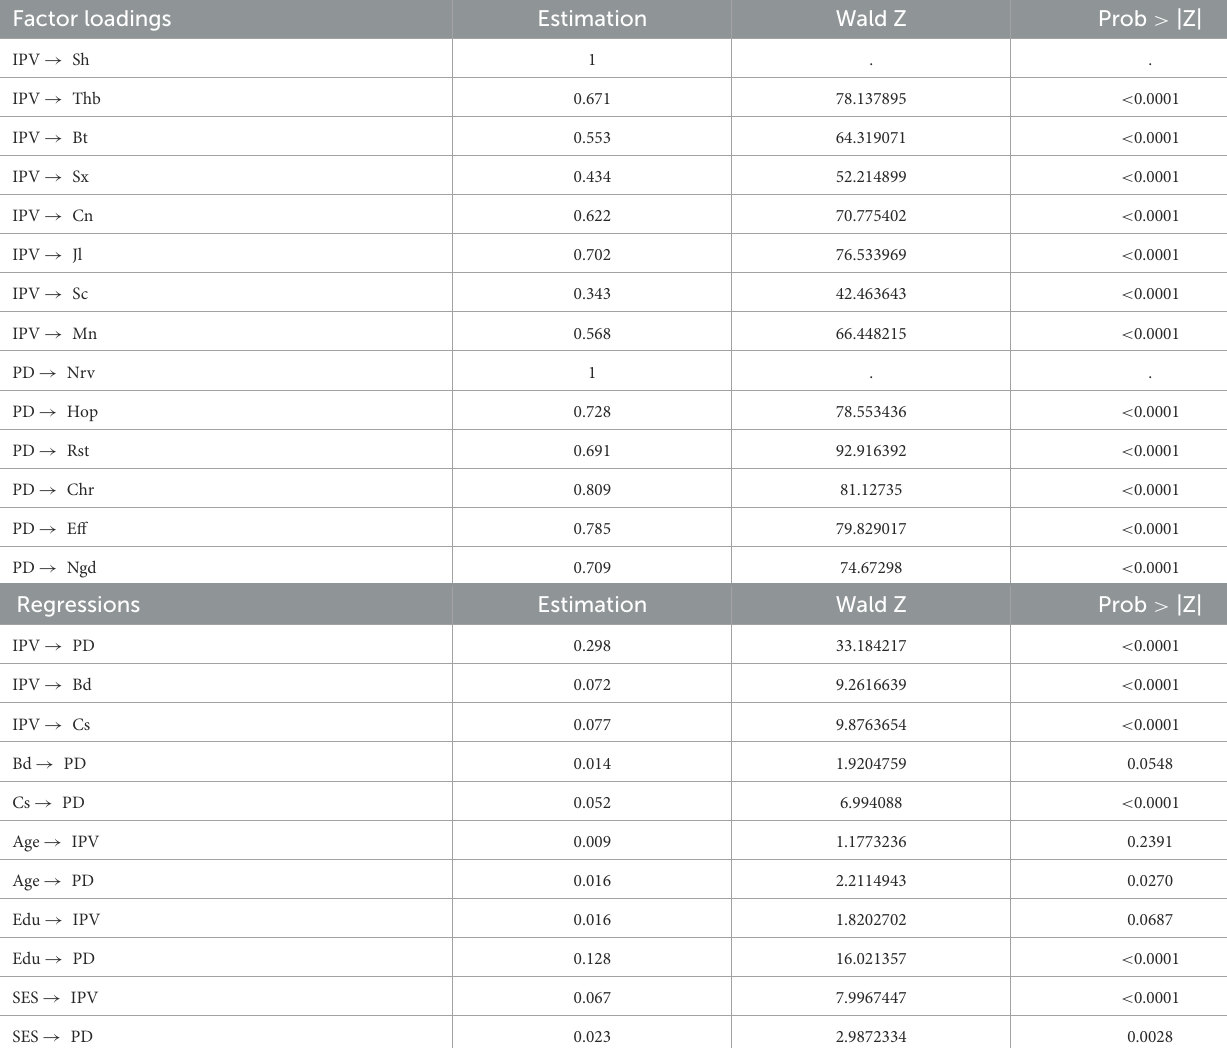
TABLE 3 Structural equation model between IPV and PD mediated by Bd and Cs: standardized parameters in women. Factor loadings